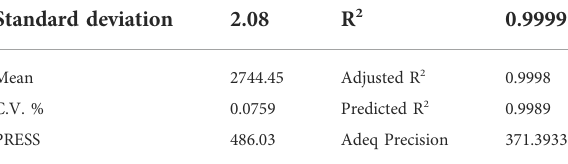
TABLE 5 Standard deviation and R 2 for the Entropy generation